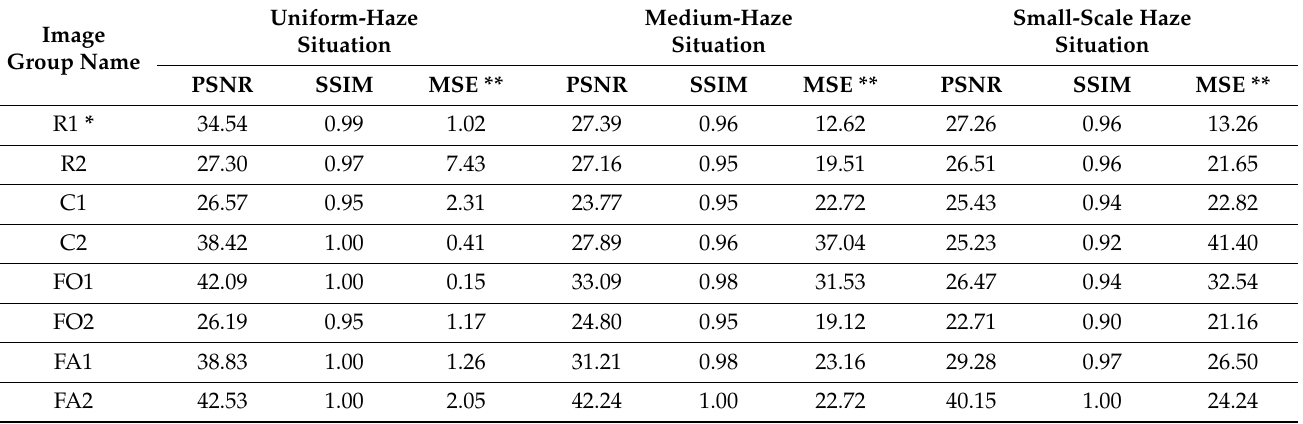
Table 3. Quantitative evaluation results of one-step DRL_Dehaze methods for different dehazing Table 3. Q uantitative e valuation results of one-step DRL_Dehaze methods for different dehazing scales in the scales in the images.